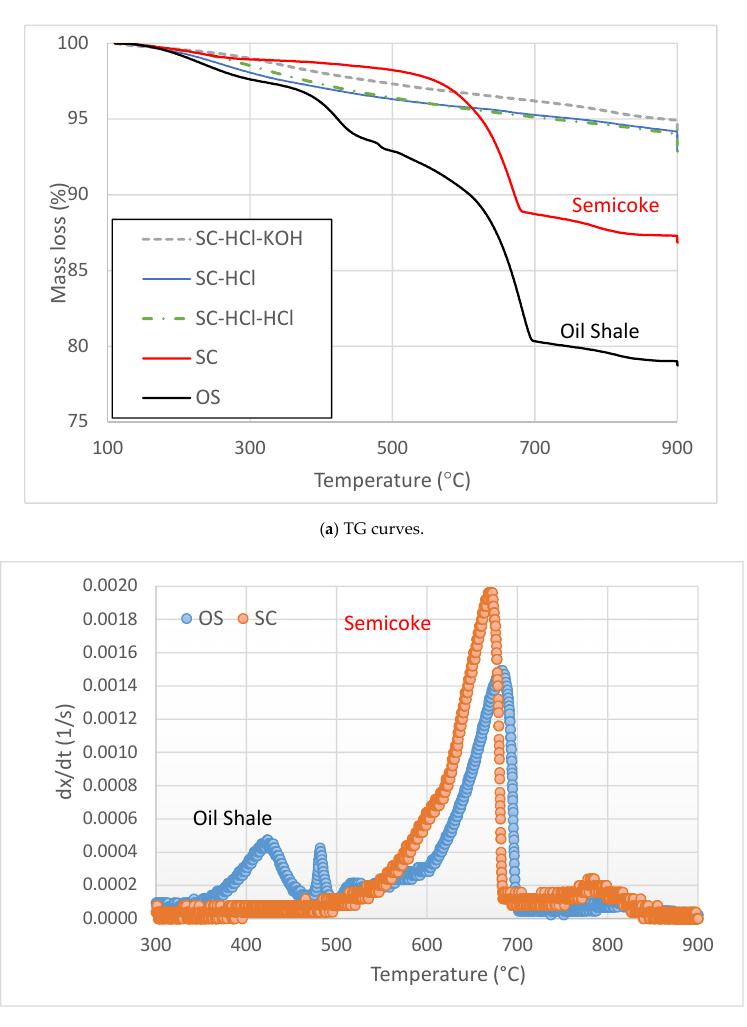
Figure 2. Thermogravimetric analysis of raw, pyrolyzed, and demineralized samples for pyrolysis of samples at 10 °C/min under high purity nitrogen.